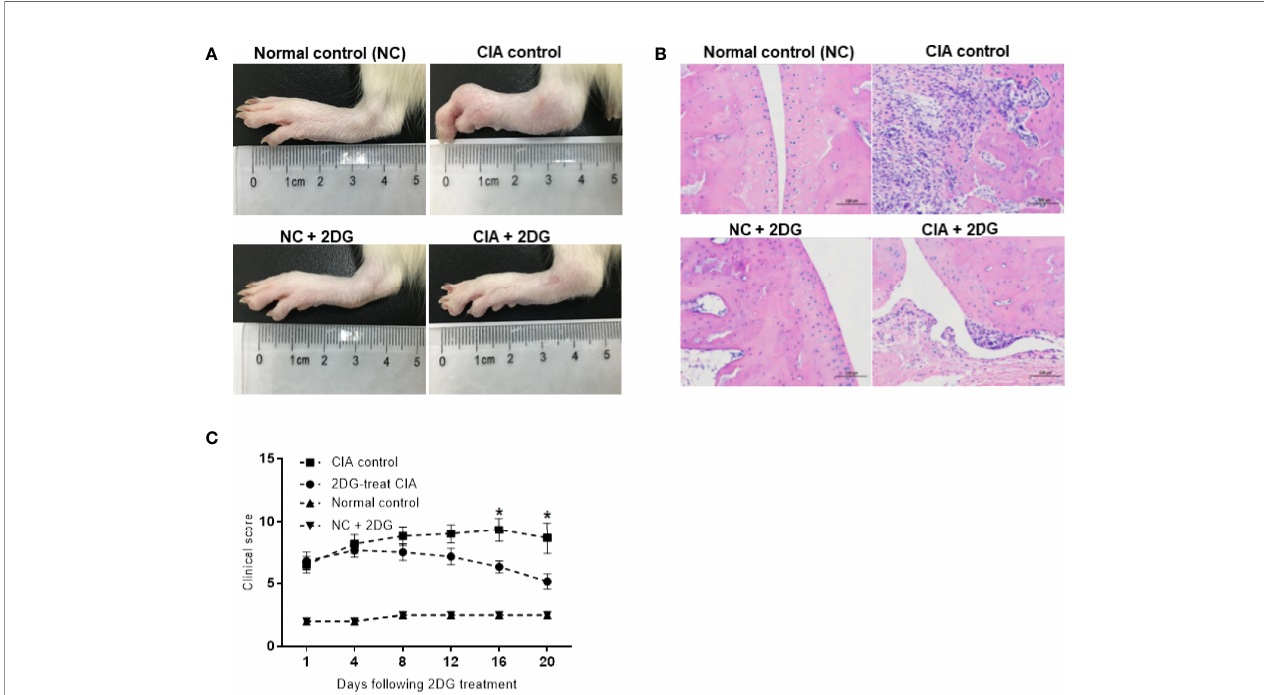
FIGURE 1 | The effect of 2-DG on CIA rats. ( A) Photographs of paws from the CIA rats following PBS (n=6) or 2-DG (n=6) treatment. The healthy rats (NC) treated with PBS (n=6) or 2-DG (n=6) were used as controls. (B) Representative images of the histological examination of the rat joint synovial tissues (200 x magni fi cation). (C) Clinical scores of the CIA rats treated with PBS or 2-DG. *p <